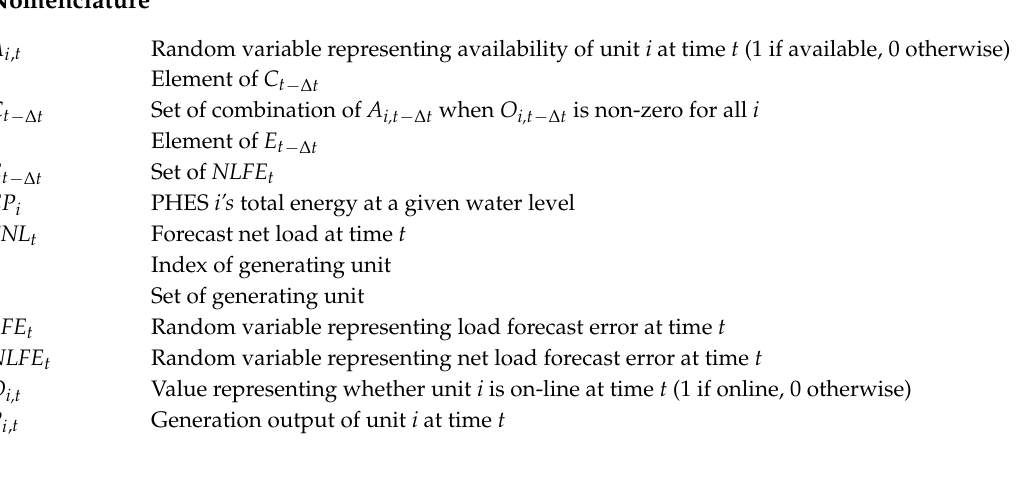
Figure 10. Hourly reserve capacity in 2029 based on the proposed method.